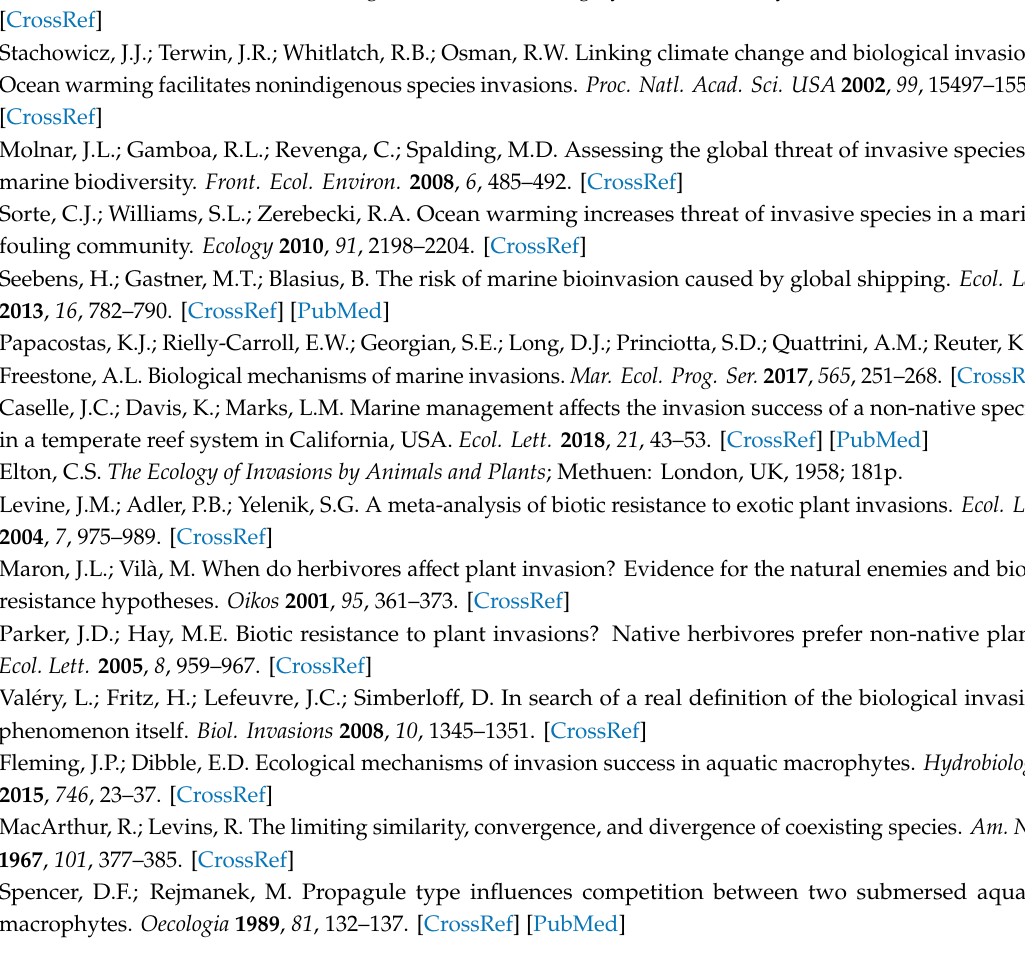
Table S1: List of native subcanopy and understory algal taxa recorded in the Sargassum horneri removal experiment, Table S2: Coe ffi cients (a = intercept, b = slope), r 2 , and p values or SE for formulas to convert size-specific density, or percent cover to damp biomass (g), Table S3: Proportional percent cover of algae adjacent to and away from sea urchin halos, Table S4: Depth distribution of Sargassum horneri and native subcanopy algae. The data presented in this manuscript are available online for download from the Long Term Ecological Research Network Data Portal, doi:10.6073 / pasta / 2c2237bb3cee86e7c6d9488e8ce2795d